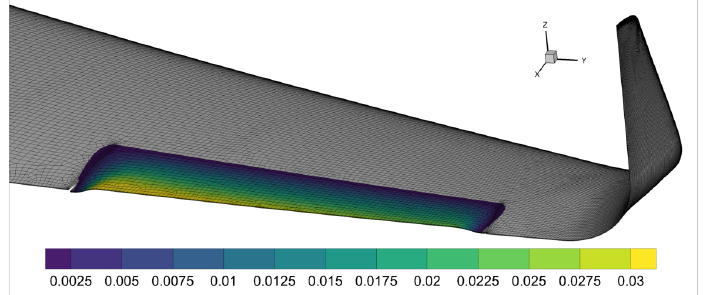
Figure 11. Surface mesh of the outboard part of the wing with deflected aileron using the mesh morphing technique. Vertical displacements in meter are